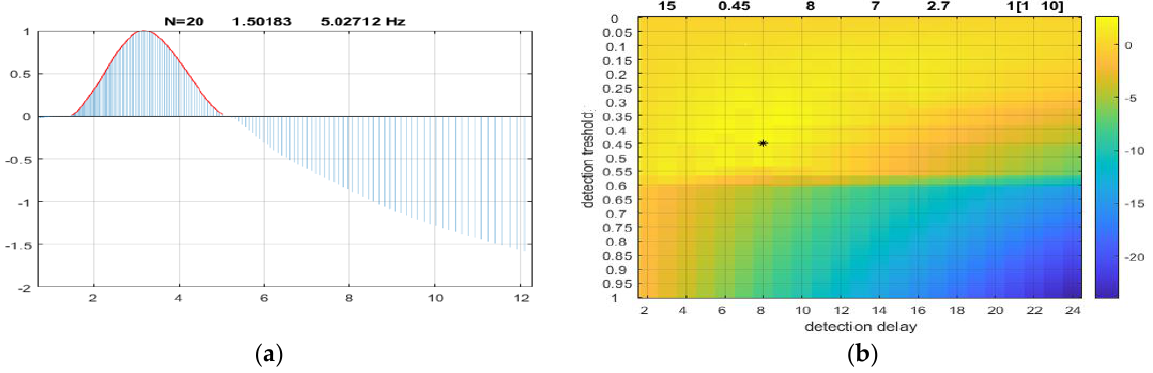
Figure 4. Results from parameter optimization technique. Panel ( a ): the proposed frequency range. The horizontal axis is the Gabor central frequency in Hz, the vertical is the relative corrected spectrum as defined by Equation (5); Panel ( b ): the optimal detection parameters. Vertical axis is the threshold measured as dimensionless quantity between zero and one. The horizontal axis represents the N-parameter, the detection delay measured in number of windows. The color code is the value of the cost-function given by Equation (7).